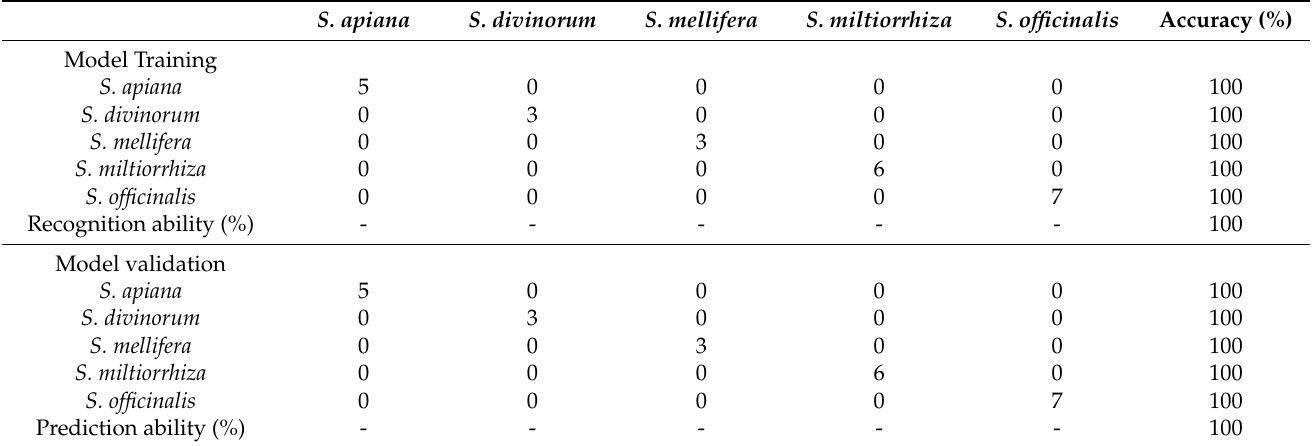
Table 3. Summary of classification results obtained by the PLS-DA model.